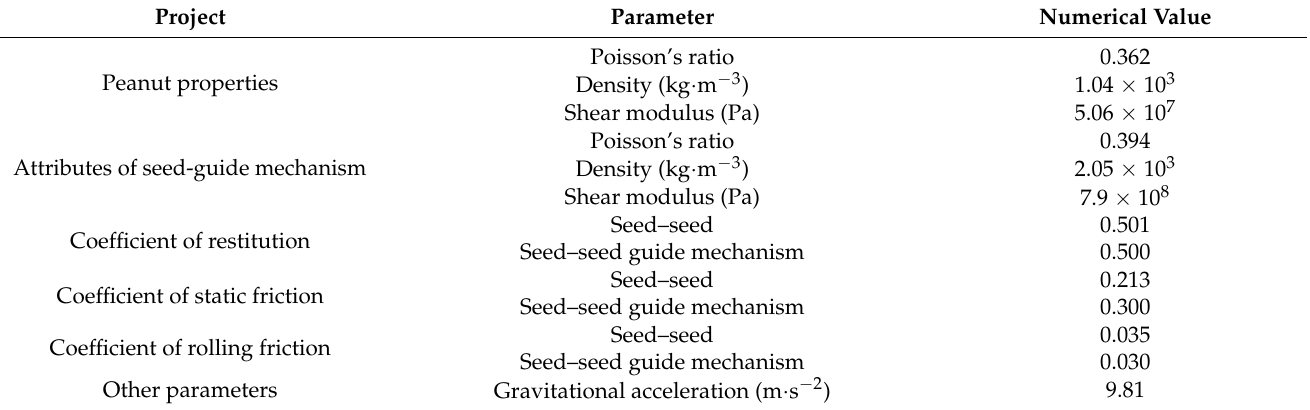
Table 1. Simulation parameter